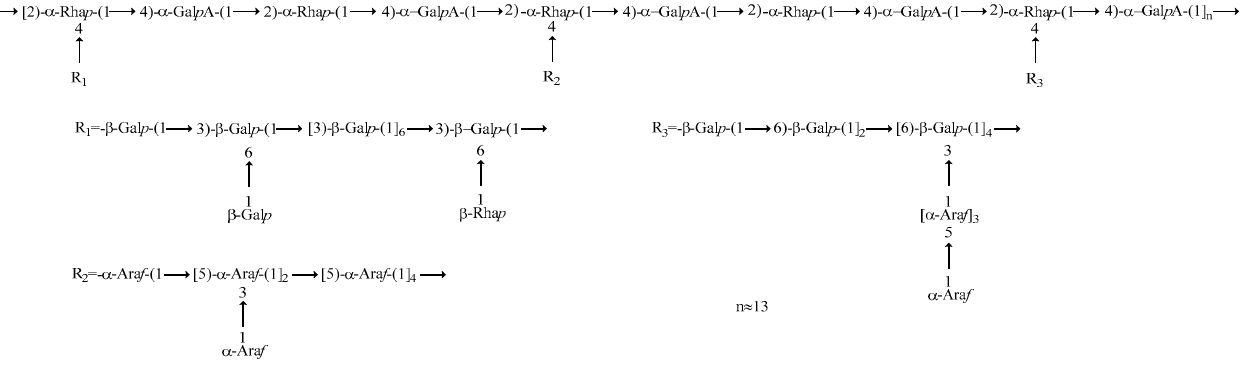
Figure 3. The hypothetical structure of the repeat unit of the glycan of LRGP5. The composition of water-soluble polysaccharides is complex; the core structure is mainly composed of arabinose and galactose, as well as Rha, GalA, Xyl, Man, and Glu. FT-IR data show carbohydrate absorption peaks at 3400.38, 2930.49, 1629.66, 1411.40, 1151.44, 1078.24, 1032.50, 920.72, 864.33, 817.08, and 777.04 cm − 1 [53]. Only the structures of high-purity compounds have been determined to date, but the overall structure of wa- ter-soluble polysaccharides remains unclear. Water-soluble polysaccharide exhibit strong pharmacological activity, which is closely related to their molecular weight, composition, location, and other structural fac- tors. In previous reports, microwave-assisted extraction and 95% ethanol precipitation were used to obtained water-soluble polysaccharides, which were hydrolyzed with tri- fluoroacetic acid, enzymatically digested, and analyzed by gel electrophoresis and HPTLC methods. The results showed that polysaccharides existed in β -1,3-glucosidic, α - 1,4-galactosiduronic, and α -1,5-arabinoside linkages. LRGP1 has an estimated molecular weight of 56.2 kDa. GC analysis suggested that LRGP1 was composed of Rha, Ara, Xyl, Man, Glu, and Gal in a molar ratio of 0.65:10.71:0.33:0.67:1:10.41. The main chain is com- posed of (1 → 3)-linked Gal and branches joined by (1 → 5)-linked Ara, (1 → 2)-linked Ara, (1 → 6)-linked Gal, (1 → 3)-linked Gal, (1 → 4)-linked Gal, and (1 → 2,4)-linked Rha. Based on this analysis, the terminal of the branches was determined to be composed of Ara, Xyl, Man, and Glu [39]. Gong et al. isolated water-soluble glycoconjugate (LBLP5-A) from Lycium barbarum leaves with 93.7% carbohydrate content and 4.6% protein content.